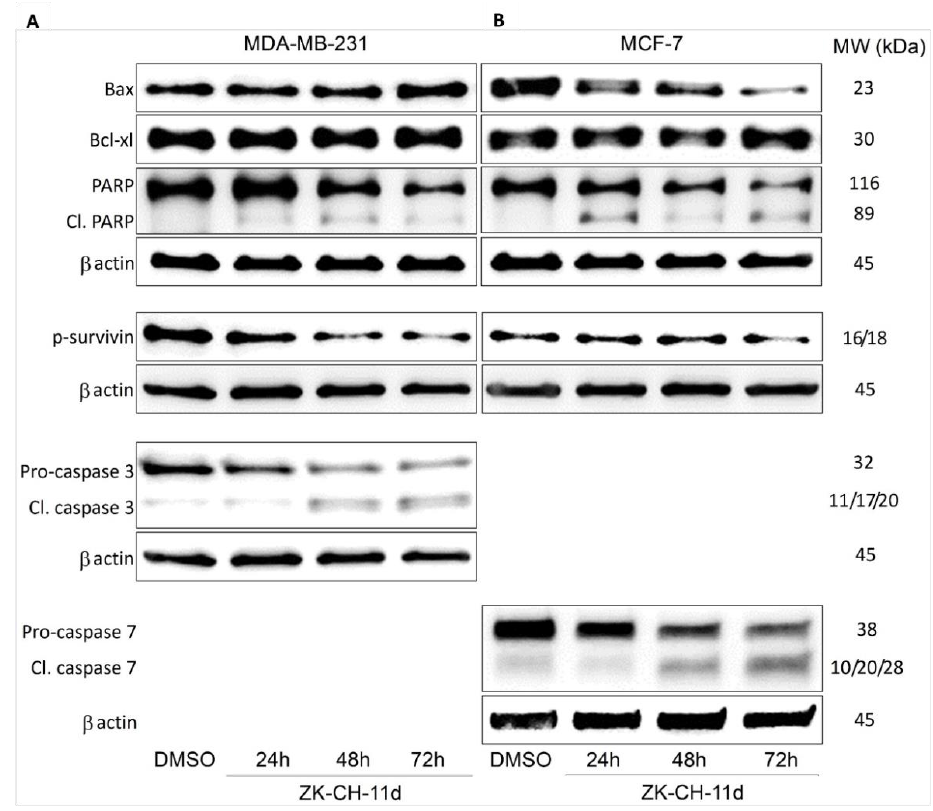
Figure 9. Western blot analysis of apoptosis-related proteins in MDA-MB-231 ( A ) and MCF-7 ( B ) cells after treatment with ZK-CH- 11d at a concentration of 40 μmol/L for 24, 48, and 72 h of treatment.